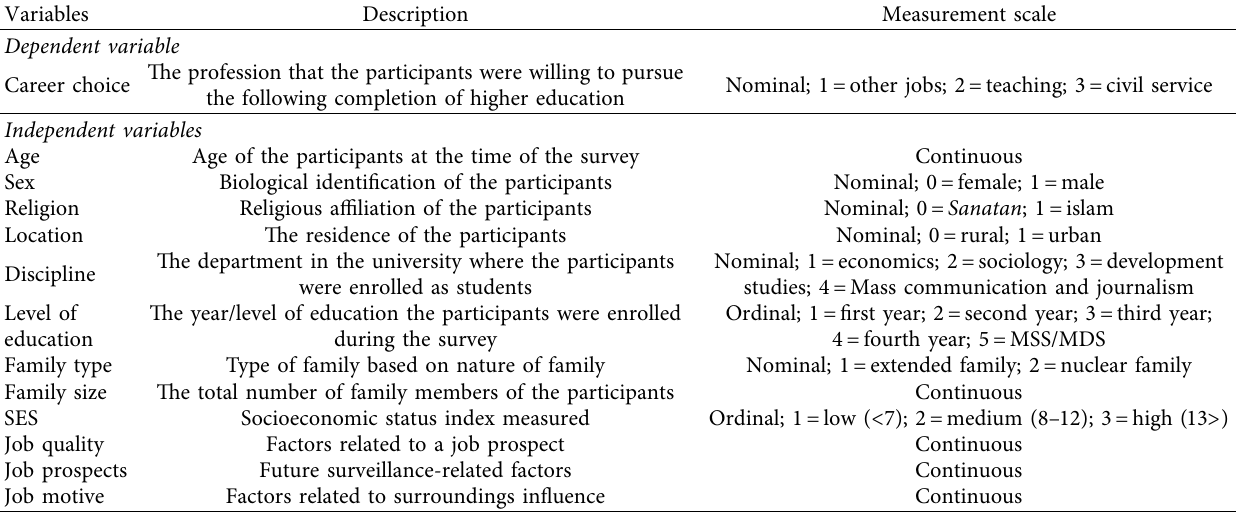
Table 2: Operational definitions of variables and their